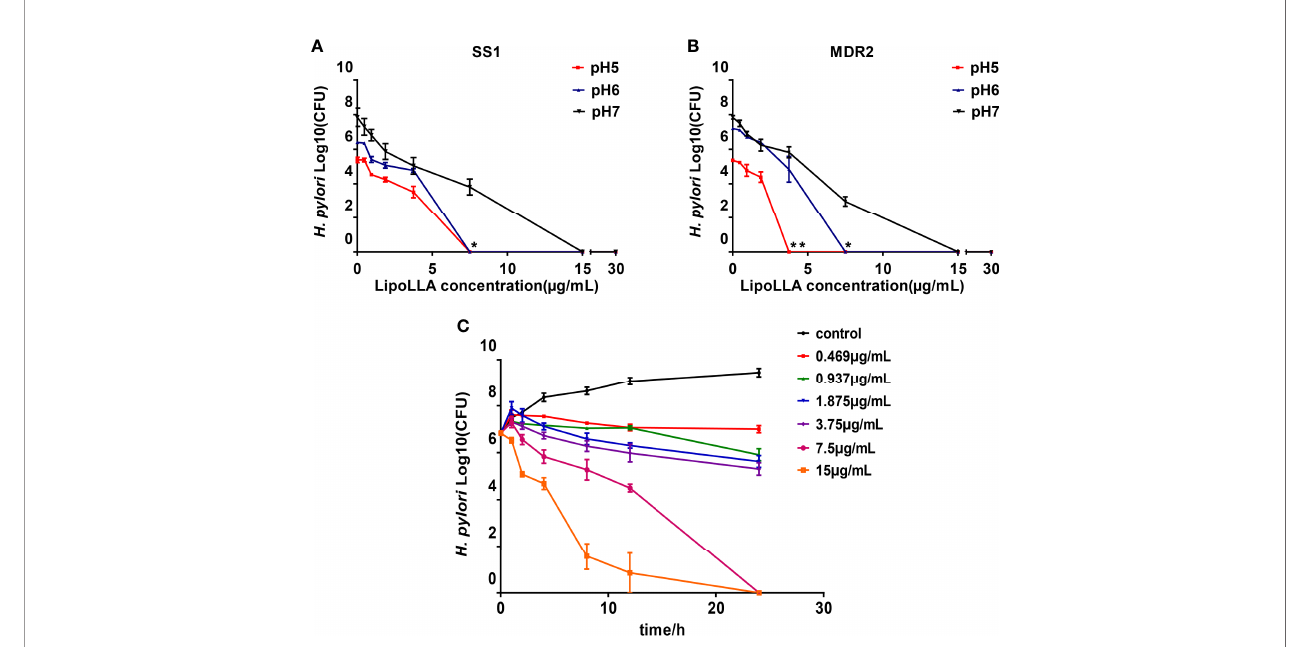
FIGURE 3 | In fl uence of pH and time on the bactericidal effect of LipoLLA. The concentration bactericidal curve of LipoLLA to SS1 (A) and a multidrug resistant strain MDR2 (B) at different pH. Time sterilization curves of SS1 with different concentrations of LipoLLA (C) . *P < 0.05; **P < 0.01, the number of viable bacterial colonies at pH=5 or pH=6 was signi fi cantly different from that at